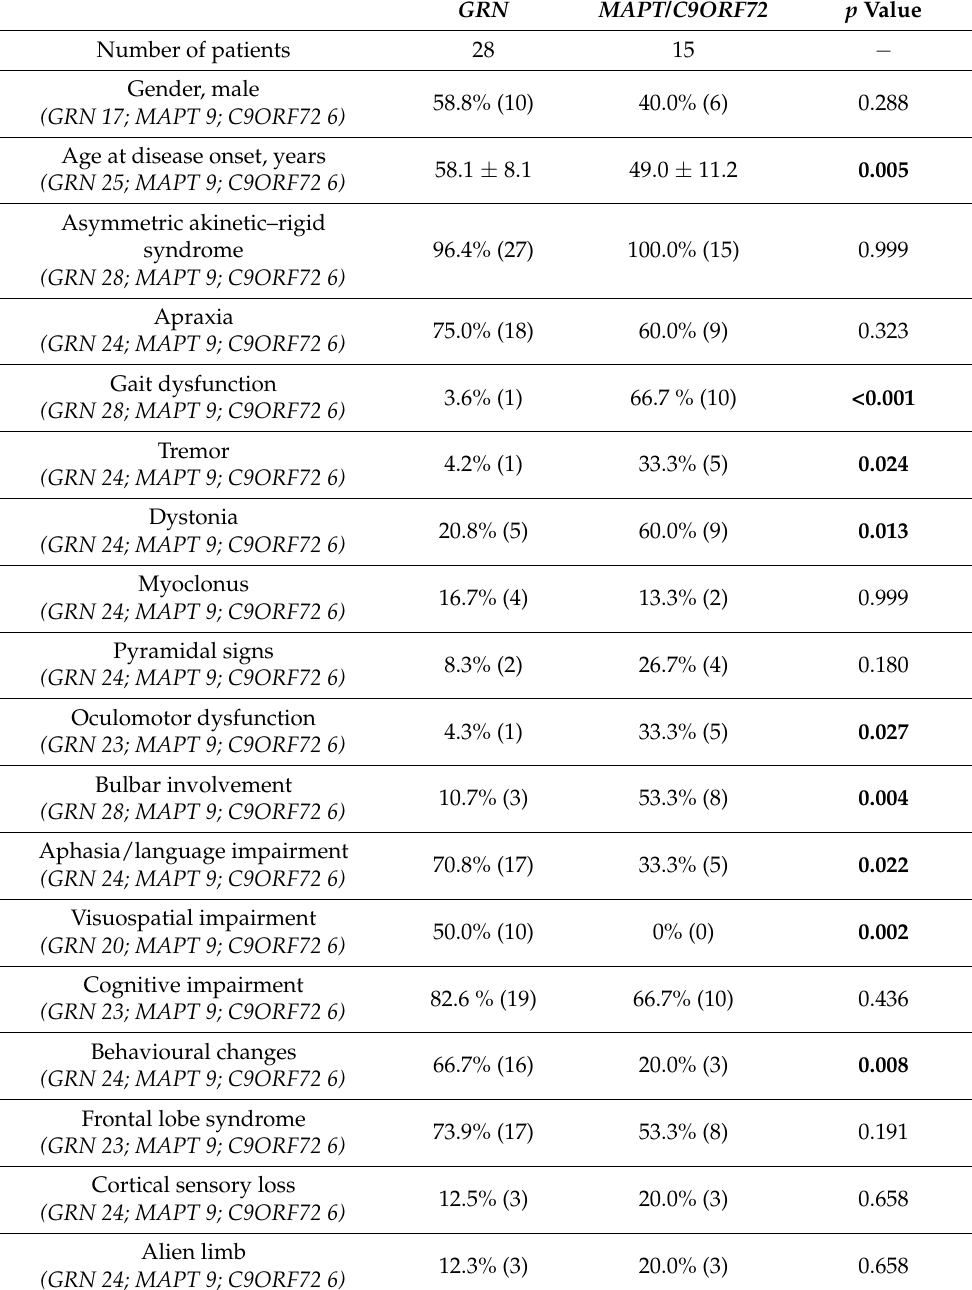
Table 2. Comparison between GRN and MAPT/C9ORF72 carriers. Statistically significant results are in bold; the threshold for statistical significance was p <